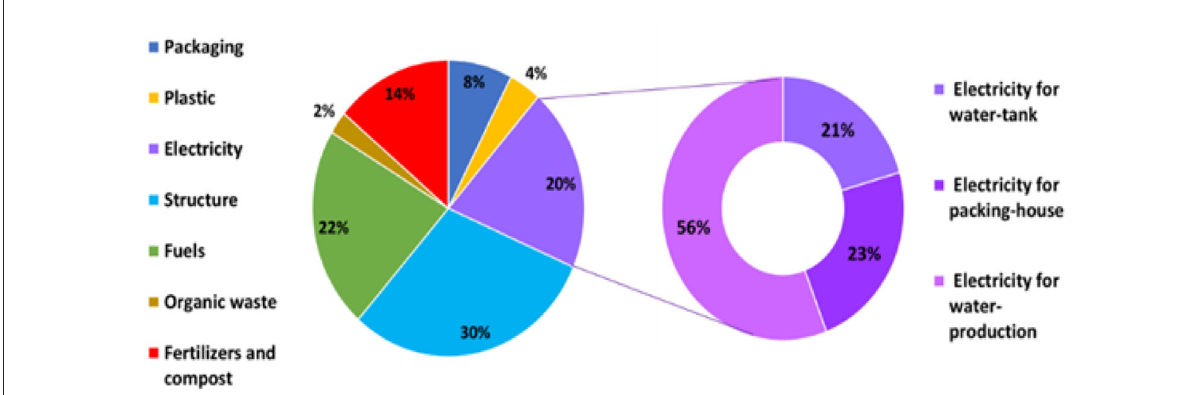
FIGURE5 Contributing the main components to the carbon footprint. (Left) : Main components relative contributing to the average CF (per ton of PGH tomatoes), percentage out of total contribution. (Right) : Breakdown of the emissions from the electricity consumption into the estimated contribution of the main operations to the total kgCO2e-1 emissions from electricity